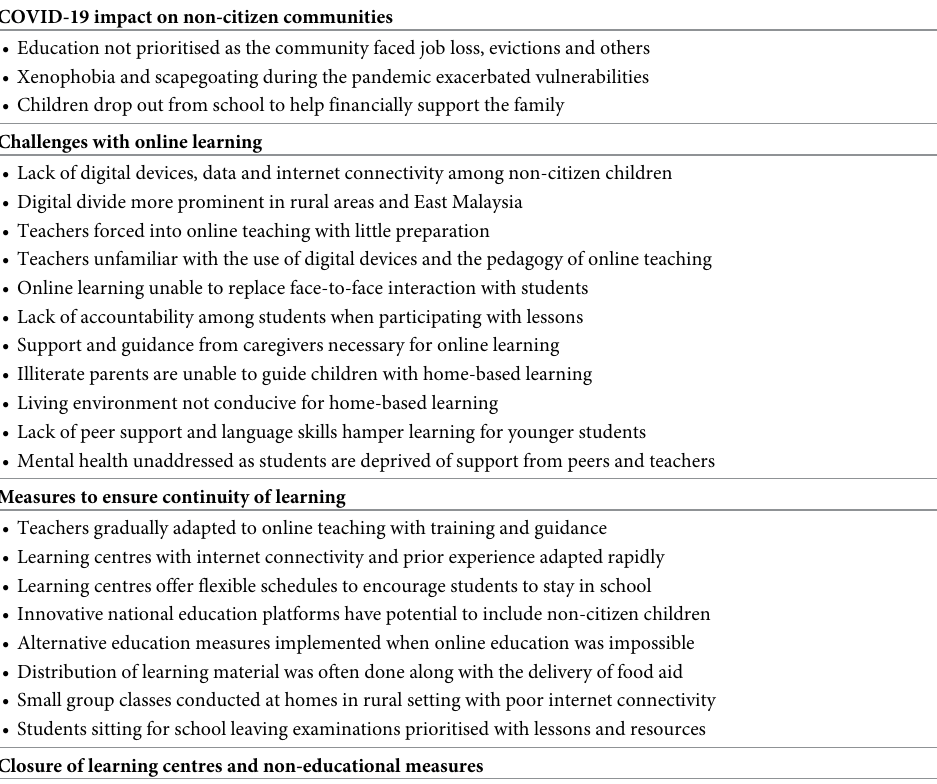
Table 2. Main findings of the